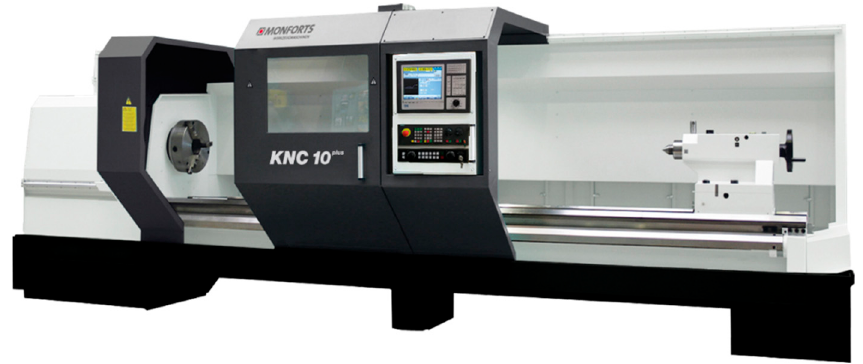
Figure 2. Test machine tool—MONFORTS KNC10plus with MTC controller. Source: R&D Steuerungstechnik GmbH & Co. KG.